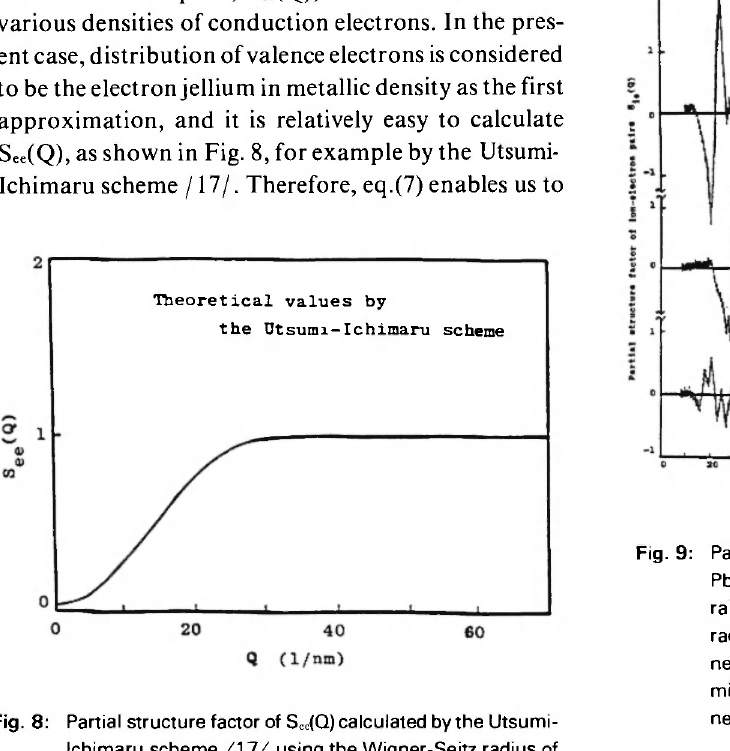
Fig. 8: Partial structure factor of S CC (Q) calculated by the Utsumi- Ichimaru scheme /'\ 7/ using the Wigner-Seitz radius of 2.25 a.u. as an example.